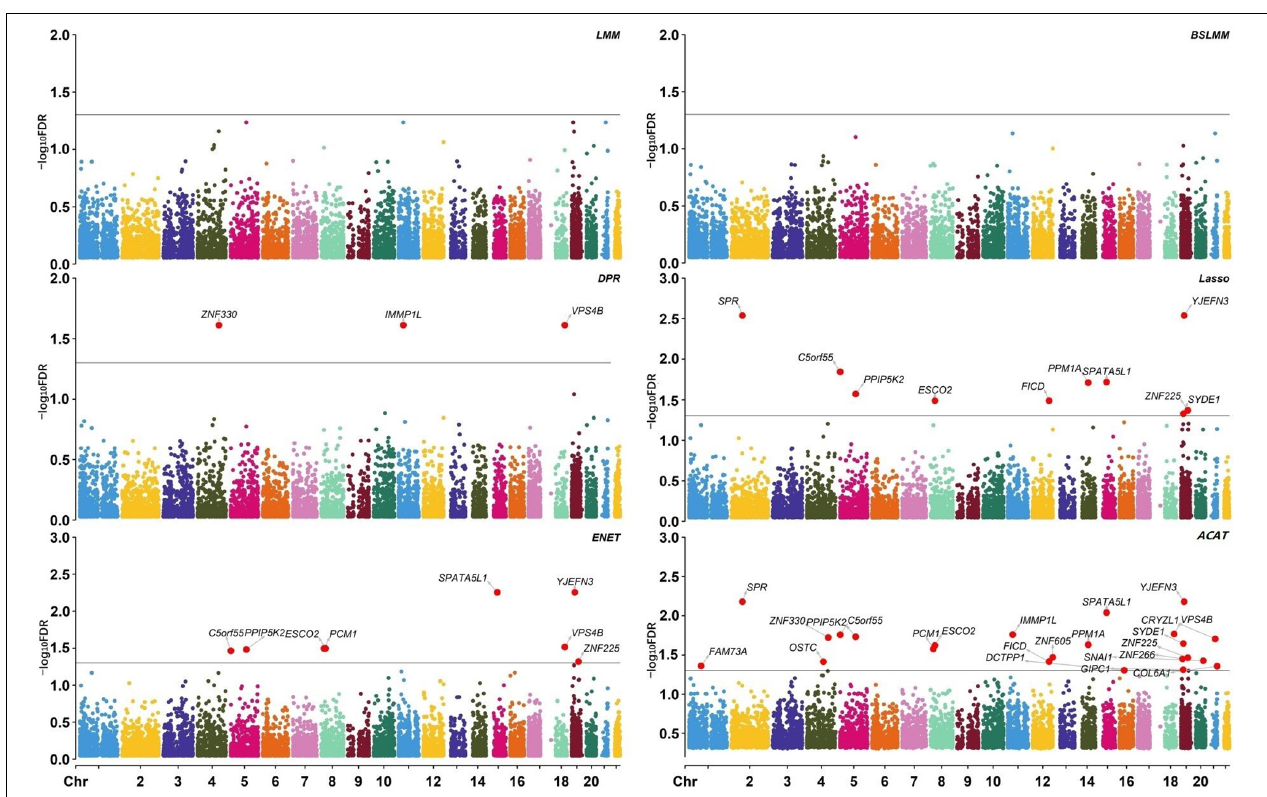
FIGURE 5 | Manhattan plot showing the significance of all genes. Each plot is in a -log10 [false discovery rate (FDR)] scale. Genes with -log10 FDR > 1.3 (i.e. FDR < 0.05) are highlighted. DPR, Latent Dirichlet Process Regression; ENET, elastic net; ACAT, aggregated Cauchy association test.